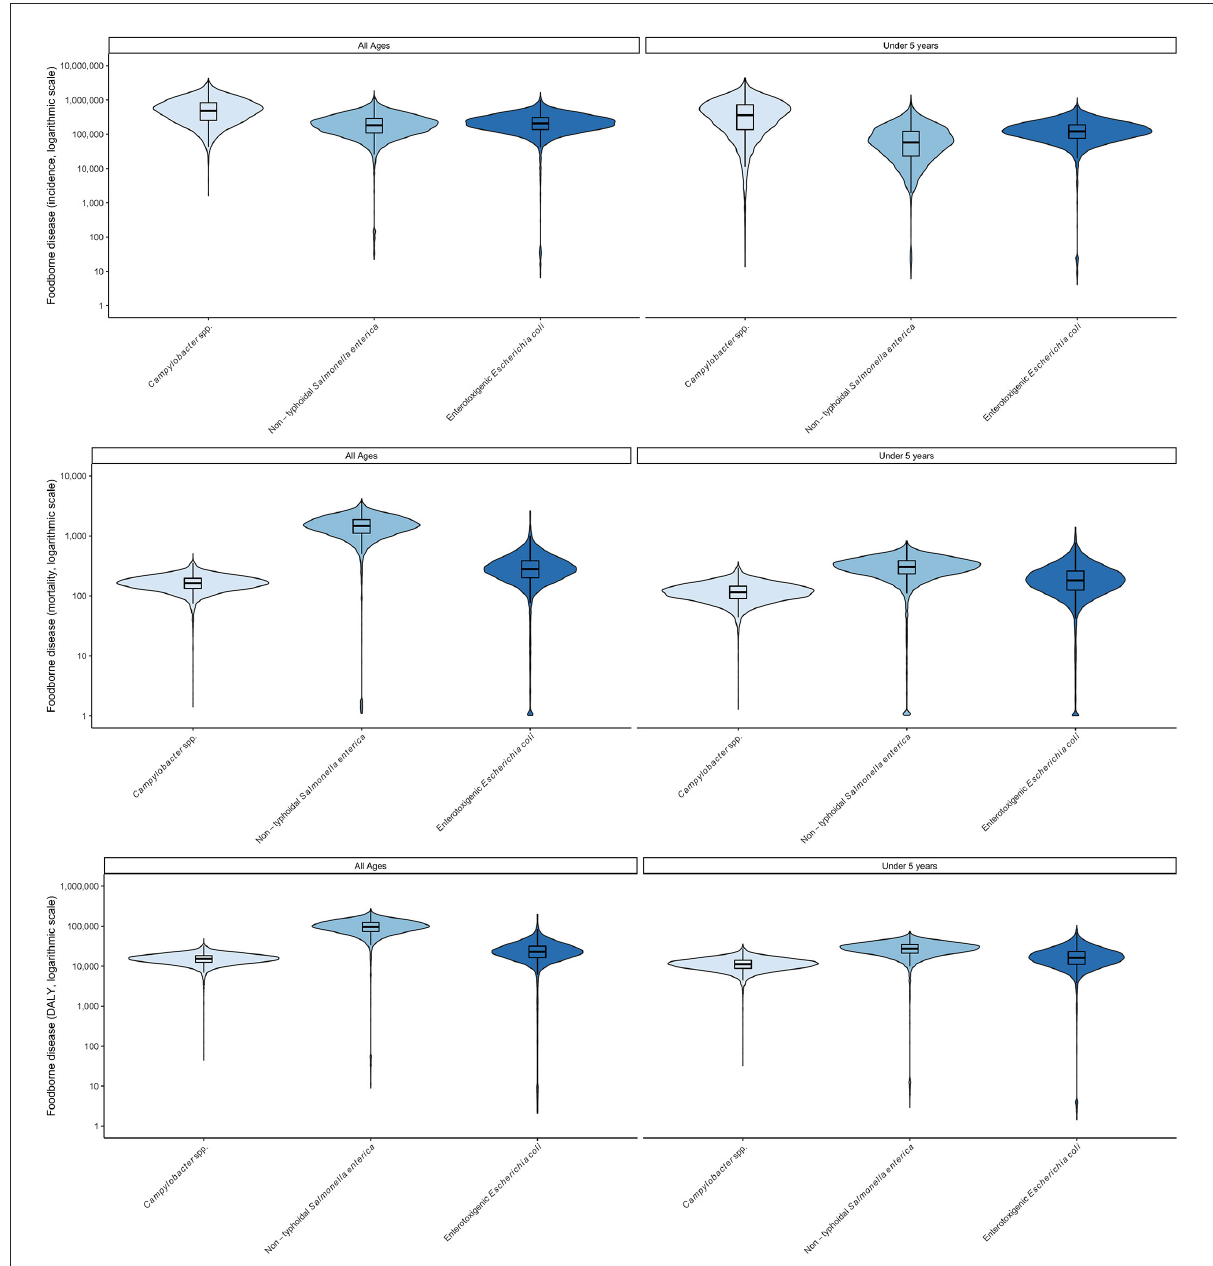
FIGURE1 Uncertainty in foodborne disease burden for three bacterial hazards and age groups in Burkina Faso in 2017 (all ages) according to WHO FERG (1), updated according to the Global Burden of Disease study (8). (Top) incidence; (Middle) mortality, (Bottom) DALYs. Violin plots display two mirror images of the probability density function of a distribution, smoothed by a kernel density estimator. Embedded in the violin plot is a boxplot, showing lines for the median, boxes for the interquartile range and whiskers for the 95% uncertainty intervals. Values beyond the 95% UI have been